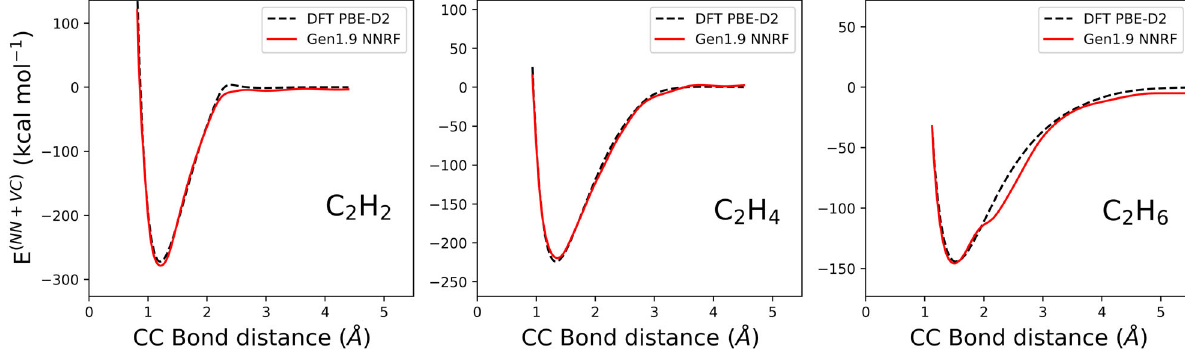
Fig. 6 The bond dissociation of sp, sp 2 , and sp 3 hybridization. The bond dissociation of acetylene, ethylene, and ethane using DFT PBE-D2 and Gen1.9 NNRF.